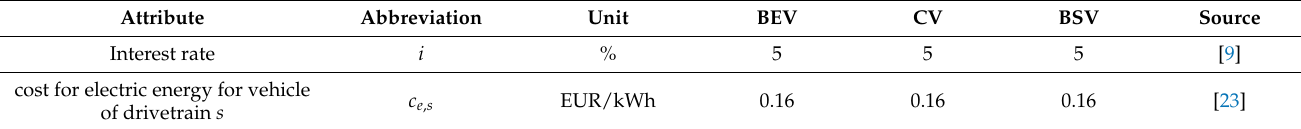
Table 5. General parameters for calculation.